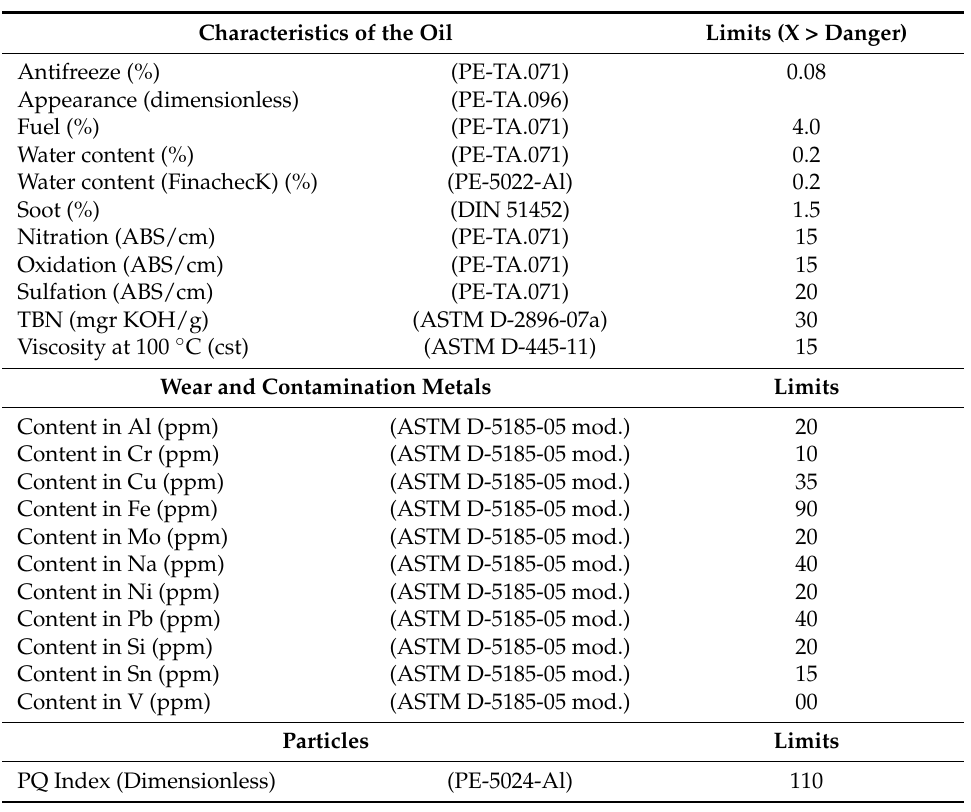
Table 1. Limits for the various